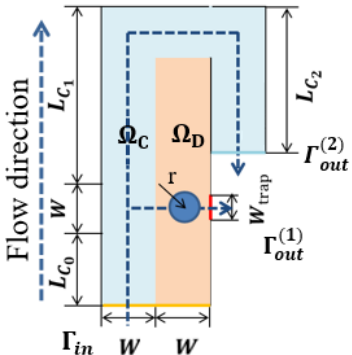
Figure 1. The computational domain 𝛺 = 𝛺 (cid:2887) ∪ 𝛺 (cid:2888) of a single-cell capture unit with the capture channel perpendicular to the inlet channel, where 𝛺 (cid:3005) is the design domain, and 𝛺 (cid:3004) is the bypass